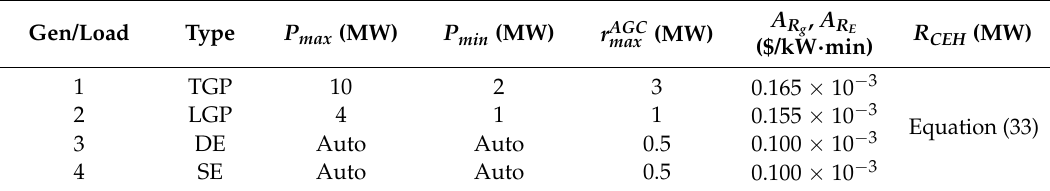
Table 2. Numerical values implemented to parameterize the generation and efficient power plant (EPP) model.